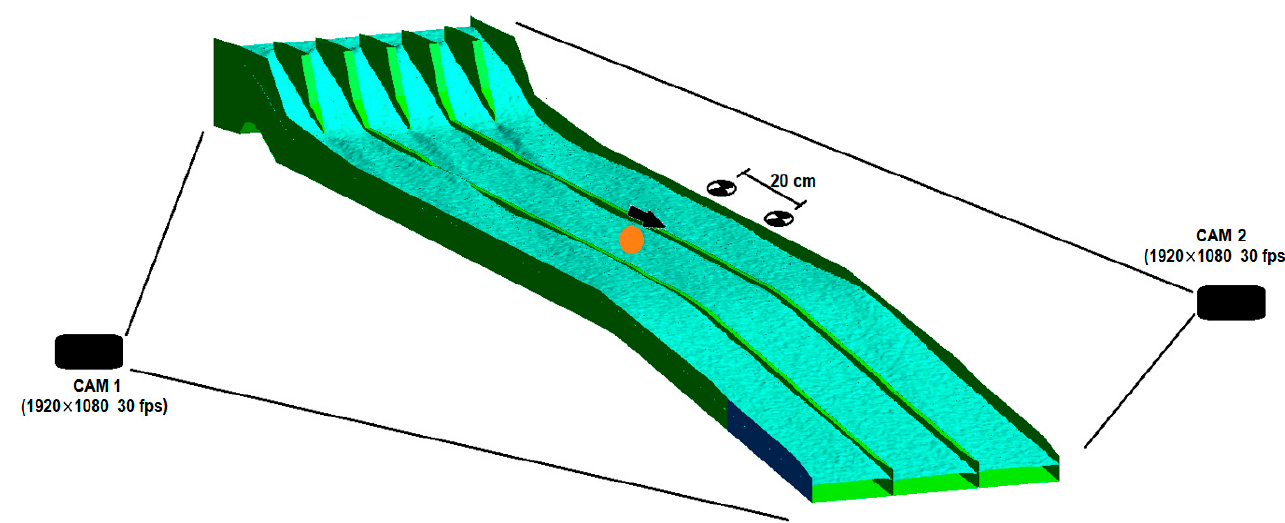
Figure 9. The apparatus and equipment used in the experiment.